Question: Give a one-sentence summary of this figure.
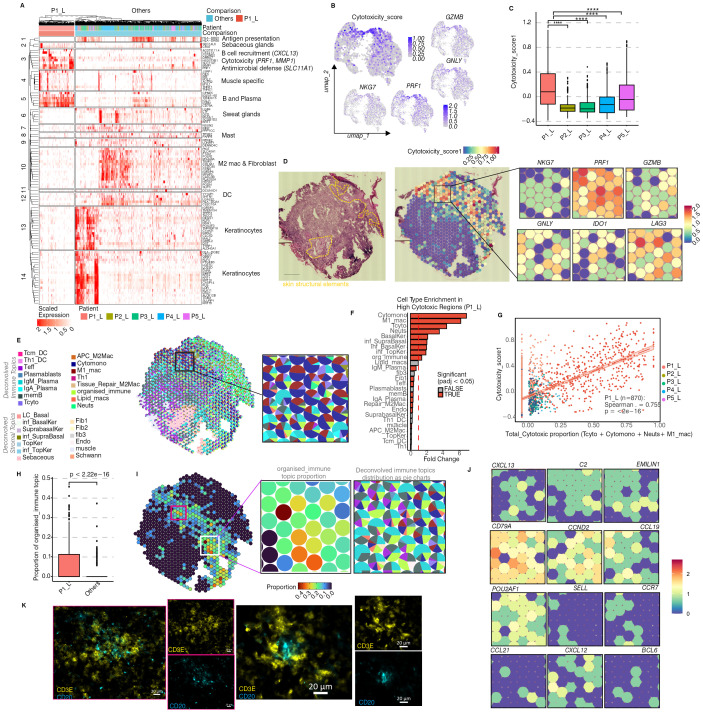
Answer: Cytotoxic immune response and tertiary lymphoid structures in P1. (A) Heatmap of top 100 DEGs in P1_L vs other lesional skin (P2-P5 L) (padj < 0.05, log2FC > ± 0.25; Wilcoxon) (B) UMAP of cytotoxicity signature in lesional skin (P1-P5). Top: composite score; right/below: four cytotoxic effector genes. (C) Cytotoxicity score across all patients (exploratory spot-level comparison, Wilcoxon; P1_L vs P2-P5 L). (D) Spatial map of cytotoxicity score in P1_L (middle), underlying H&E histology (left) and high-magnification spatial expression of selected genes from representative region(right). (E) Topic deconvolution (pie charts) of representative area (from D). (F) Fold enrichment of topics in high (≥Q3, top 25%) vs low (<Q3, bottom 75%) cytotoxic regions of P1_L (exploratory spot-level comparison, Wilcoxon with Bejamini Hochberg correction; red dotted line: log2FC =1). (G) Correlation between total cytotoxic cell abundance (Tcyto, Cytomono, M1_mac, Neuts) and cytotoxicity score. Points coloured by patient; P1_L (95% CI); ρ = Spearman’s rank. (H) Organised_immune topic proportion in P1 L vs P2-P5 L (Wilcoxon). (I) Organized_immune topic distribution in P1_L across full tissue (left), magnified region (middle; white square region enlarged), and other topics as pie charts (right). (J) Tertiary lymphoid structures (TLS) hallmark gene expression in representative areas from ( (I) ; pink and white square regions). (K) Multiplex immunofluorescence (IF)of two putative TLS from P1_L showing CD3E+ T cells (top) and CD20+ B cells (bottom) in magnified regions. Scale bar, 20µm.